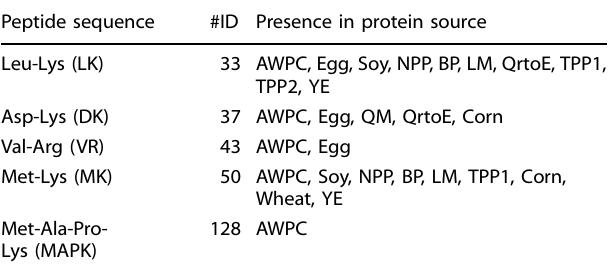
Table 2. Identi fi ed peptide sequences with at least a de novo score of